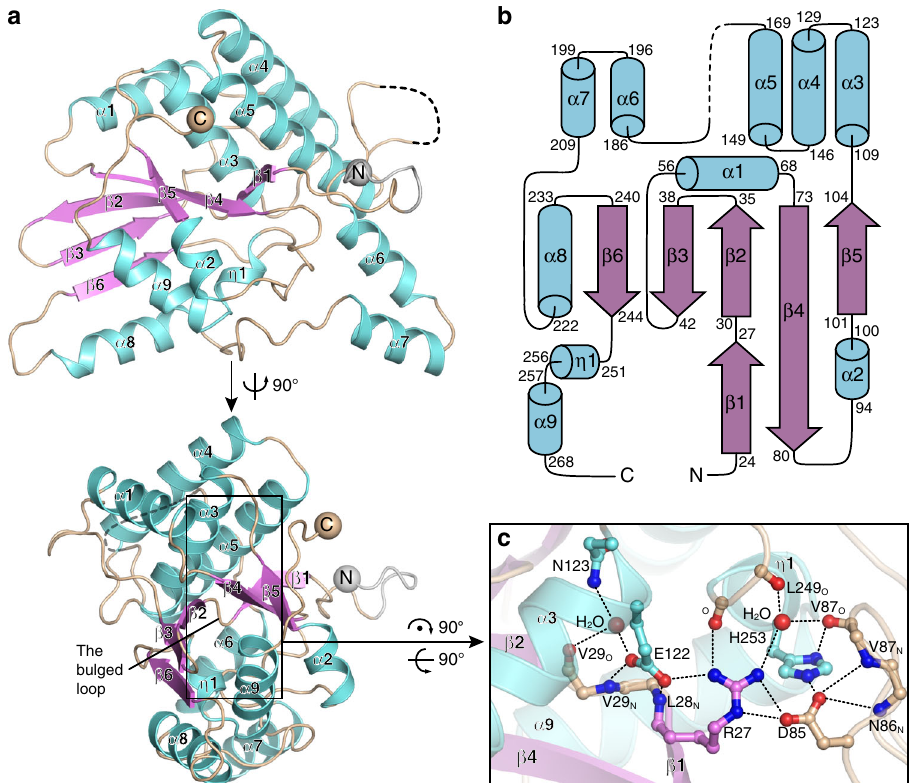
Fig. 1 Overall structure of BBRF2 Δ . a Structure of BBRF2 Δ . Helices and β -strands are speci fi ed and coloured cyan and magenta, respectively. The vector encoded residues are coloured grey. The N- and C-termini are indicated by spheres. The vector-encoding part of the N-terminal extension is coloured grey. The disordered loop is shown as a dashed line. b Topology diagram of BBRF2 Δ . Secondary structural elements are not drawn to scale, and are coloured as in a. The boarders of the elements are speci fi ed. c Details of the hydrophilic core of BBRF2 Δ , with α 4 and α 5 removed for clarity. The main chain oxygen and nitrogen atoms involved in the contact are indicated in subscript with the corresponding amino